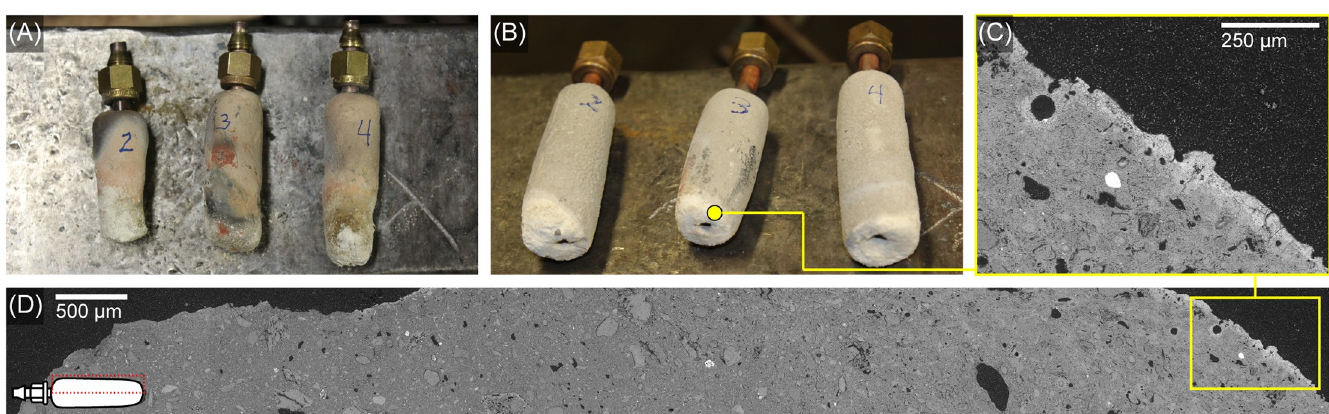
Fig 12. Experimental tuy è res after firing test and SEM analysis. (A) Tuy è res made from modern stoneware clay were heavily altered after firing and began to disintegrate at the distal ends closest to the heat source. (B) Yucata´n white clay tuy è res survived firing intact with minor alteration at the distal ends. (C) BSE micrograph of the experimental tuy è re identified in (B) showing alteration along the external edge that was in direct contact with the heat source. (D) Composite BSE micrograph of the same experimental tuy è re showing the vitrification is concentrated at the distal end. Photographs (A-B) by Elizabeth Paris. Micrographs (C-D) by Jennifer